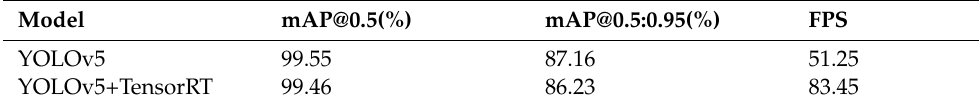
Table 1. Model Performance Comparison.